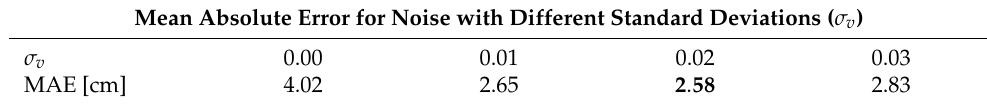
Table 4. MAE on the S 3 dataset for different amounts of noise. Window size is 3 × 3. The best performance (in bold) is achieved with a noise standard deviation σ v =